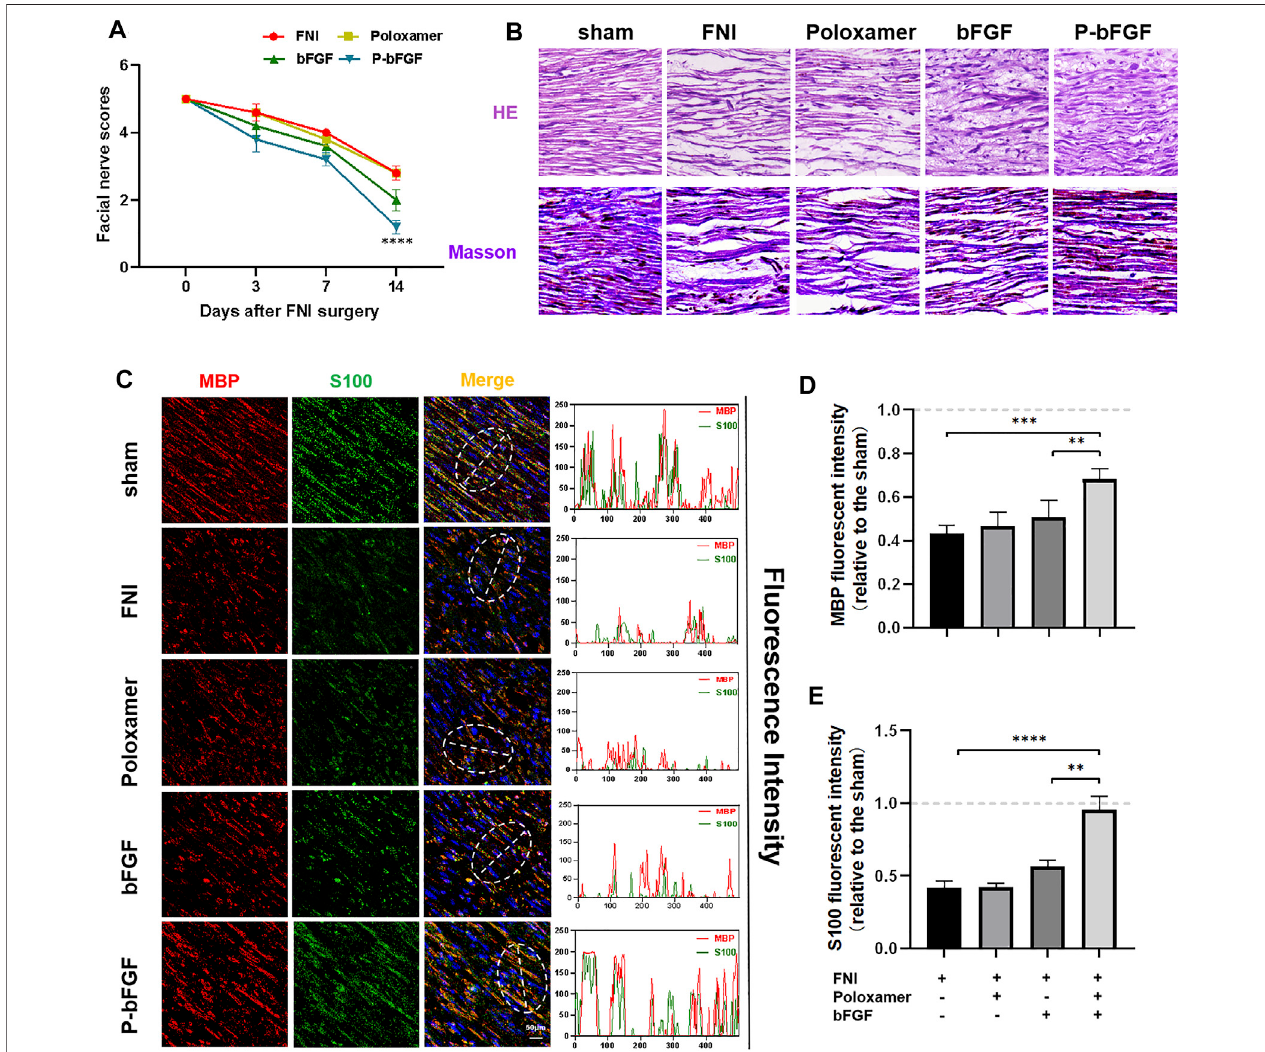
FIGURE 2 | The functional and histological recovery of the injured nerve 2 weeks after treatment. (A) Facial nerve function scoring was performed 0, 3, 7, and 14 days after surgery. The data were expressed as mean ± SEM ( n = 5); P-bFGF group vs. FNI group: **** p < 0.0001, P-bFGF group vs. poloxamer group: **** p < 0.0001. (B) InjurednerveswerestainedwithH&EandMasson ’ sstain,respectively;scalebar=100 μ m. (C) Confocallaserscanningmicrographofimmuno fl uorescence staining with anti-MBP (red) and anti-S100 (green) antibodies; scale bar = 50 μ m. The co-localization of MBP and S100 was shown by a plot pro fi le analysis in ImageJ. (D,E) QuantitativecalculationofthemeanoftheMBPandS100 fl uorescence.Thedatawereexpressedasmean±SEM( n =4);**** p < 0.0001,*** p < 0.001and ** p < 0.01. A dashed line at 1.0 represented sham group.